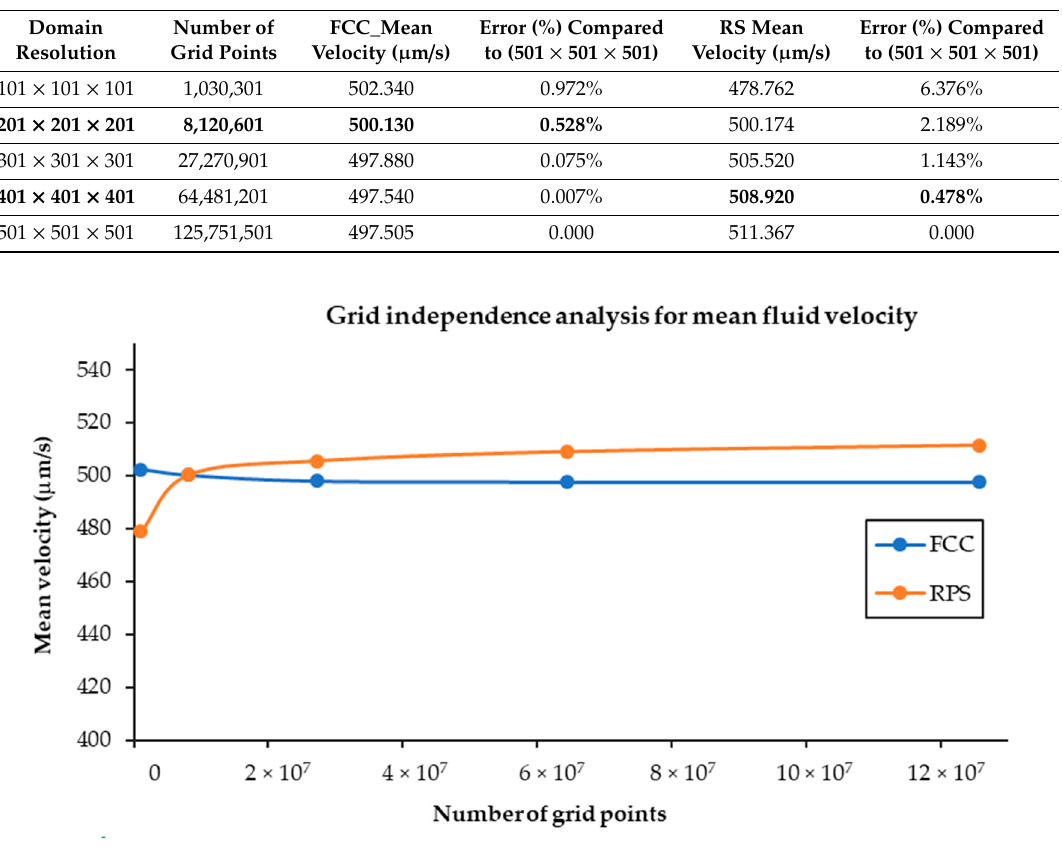
Table A1. The e ff ect of the number of mesh resolution on the mean velocity of the LBM flow field for FCC and RPS. Bold highlights the values discussed in the text.